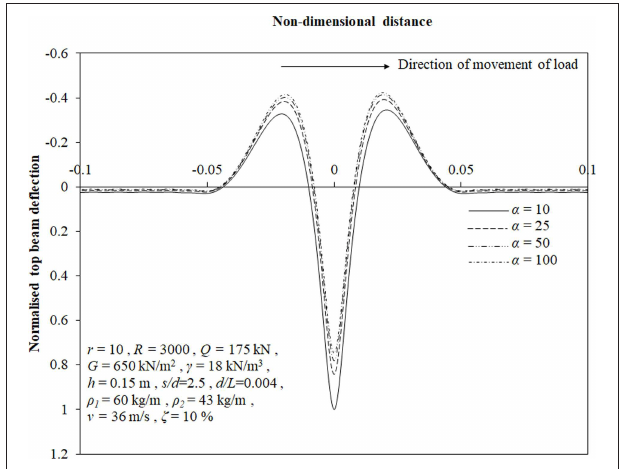
FIGURE 7 | Bending moment profile of top beam for various magnitudes of applied load.